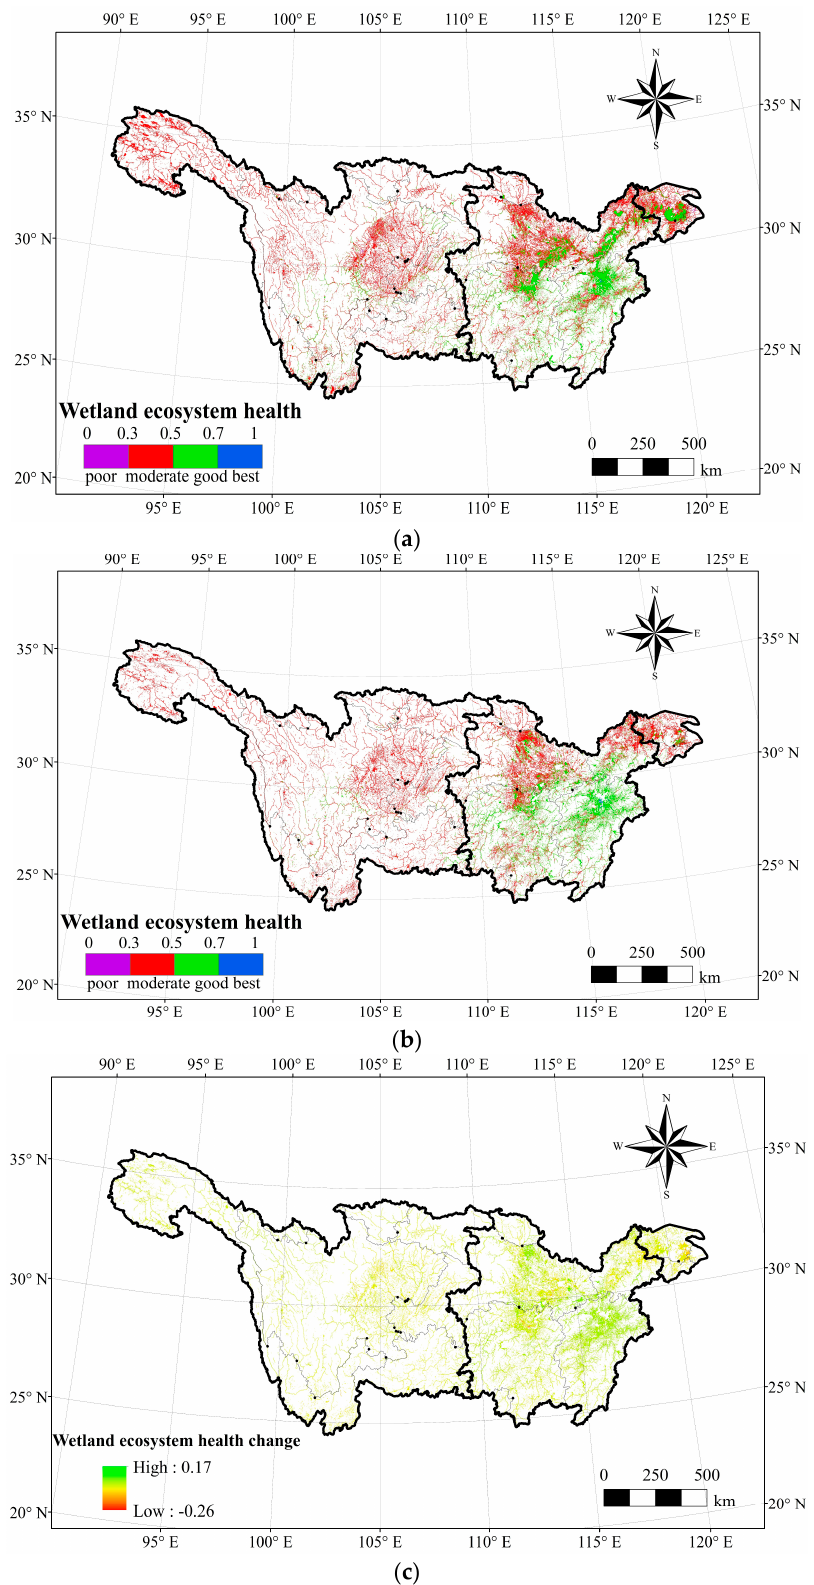
Figure 2. Spatial pattern of wetland ecosystem health in the Yangtze River Basin in 2000 and 2010. ( a ) 2000; ( b ) 2010; ( c ) Change in wetland ecological health index from 2000 to 2010.